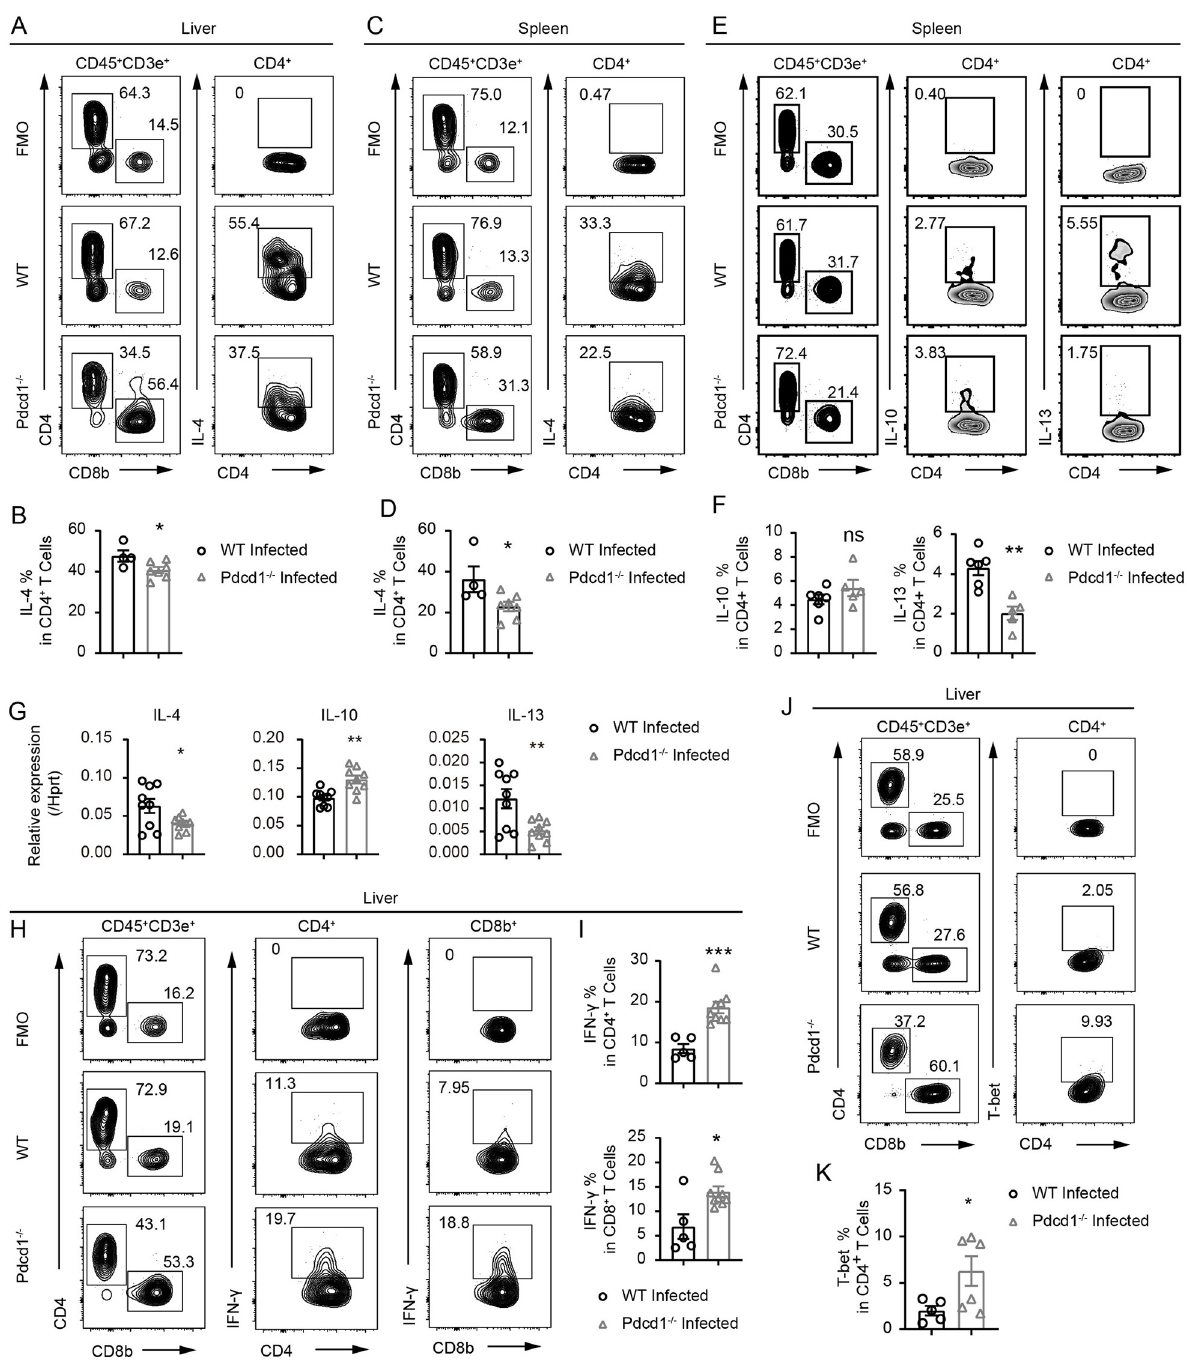
Fig 3. PD-1 deficiency suppresses Th2 differentiation and promotes IFN- γ production in liver T cells of the S . japonicum infected mice. (A-B) Flow cytometric analyses of IL-4 expression in T cells in the livers of WT and PD-1-deficient Pdcd1 −/− mice infected with S . japonicum for 8 weeks (WT mice, n = 4; KO mice, n = 7). (C-D) Flow cytometric analyses of IL-4 expression in T cells in the spleens of WT and PD-1-deficient Pdcd1 −/− mice infected with S . japonicum for 8 weeks (WT mice, n = 4; KO mice, n = 7). (E-F) Flow cytometric analyses of IL-10 and IL-13 expression in splenic T cells of WT and PD-1-deficient Pdcd1 −/− mice infected with S . japonicum for 8 weeks (WT mice, n = 6; KO mice, n = 5). (G) qRT-PCR analyses of IL-4, IL-10 and IL-13 mRNAs in T cells purified by streptavidin-coated beads from splenocytes of WT and PD-1-deficient Pdcd1 −/− mice infected with S . japonicum for 8 weeks (WT mice, n = 3; KO mice, n = 3; each sample analyzed in 3 replicates). (H-I) Flow cytometric analyses of IFN- γ expression in T cells in the livers of WT and PD-1-deficient mice infected with S . japonicum for 8 weeks (WT mice, n = 5; KO mice, n = 9). (J-K) Flow cytometric analyses of T-bet expression in CD4 + T cells in the livers of WT and PD-1-deficient mice infected with S . japonicum for 8